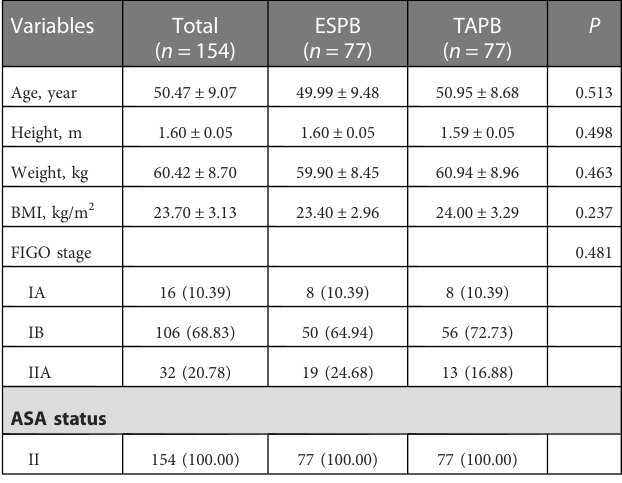
TABLE 1 Comparison of general information of erector spinae plane block group and transversus abdominis plane block group.